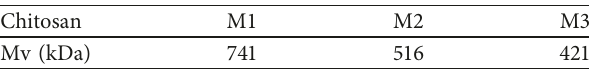
Table 2: The viscosity-average molecular weight (Mv) values of the chitosan.